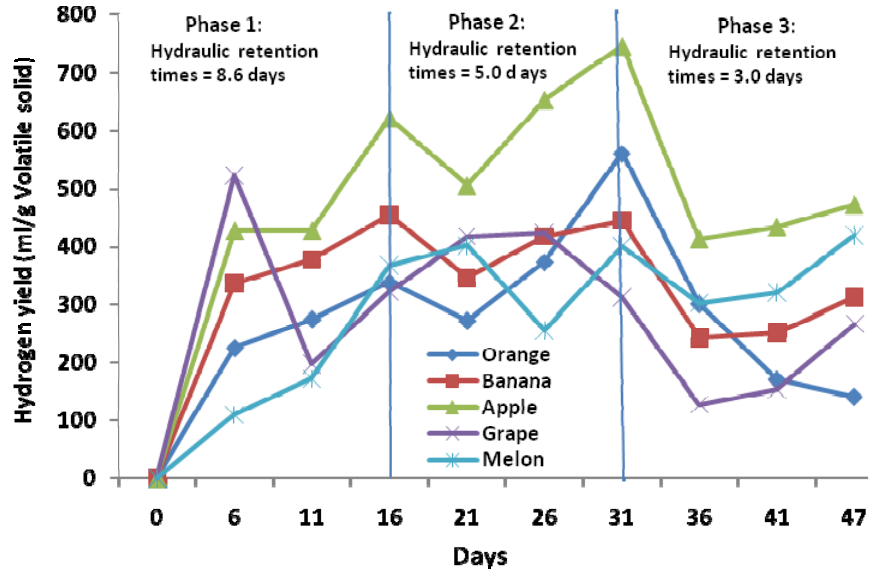
Figure 1. Hydrogen yields from the fermentation of single